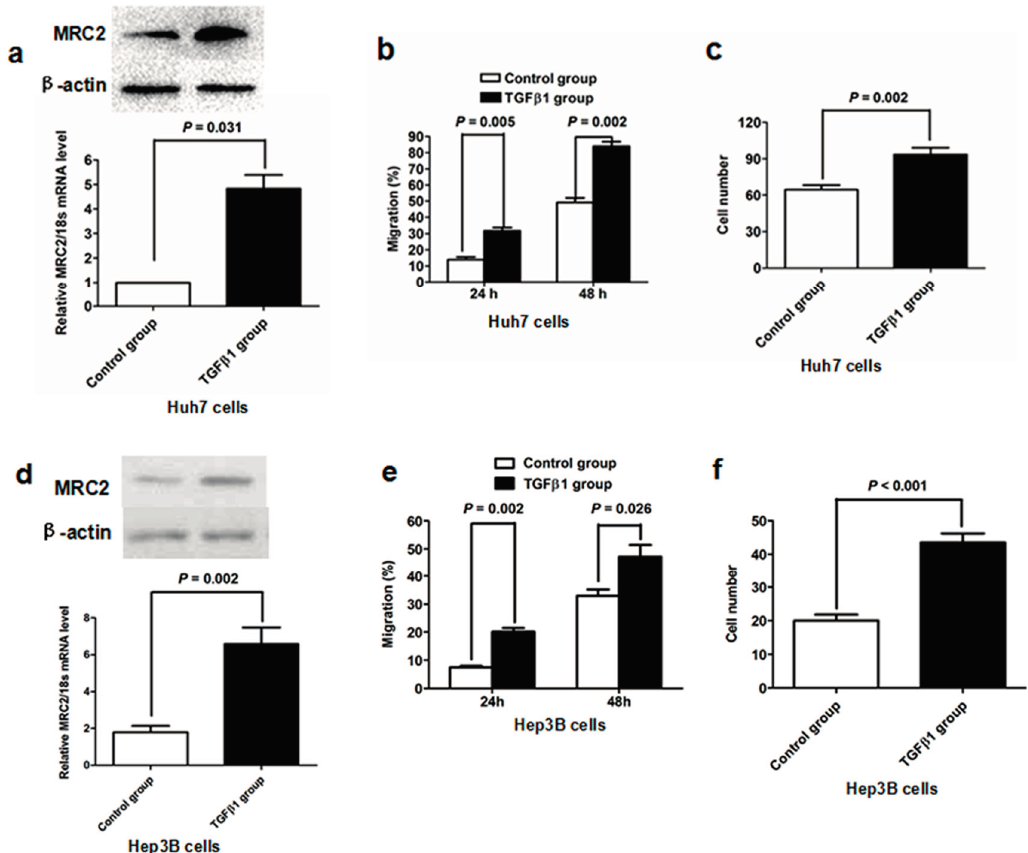
Figure 3. ( a ) As assessed by both western immunoblotting and qRT-PCR assays, TGF β 1 treatment leaded to up-regulation of MRC2 in Huh7 cells significantly; ( b ) TGF β 1 treatment promoted migration of Huh7 cells apparently; ( c ) Invasion capacity of Huh7 cells was significantly enhanced by TGF β 1 treatment ( p = 0.002); ( d ) Both qRT-PCR and western immunoblotting revealed that TGF β 1 treatment resulted in a significant increase of MRC2 expression in Hep3B cells; ( e ) The migration ability of Hep3B cells was